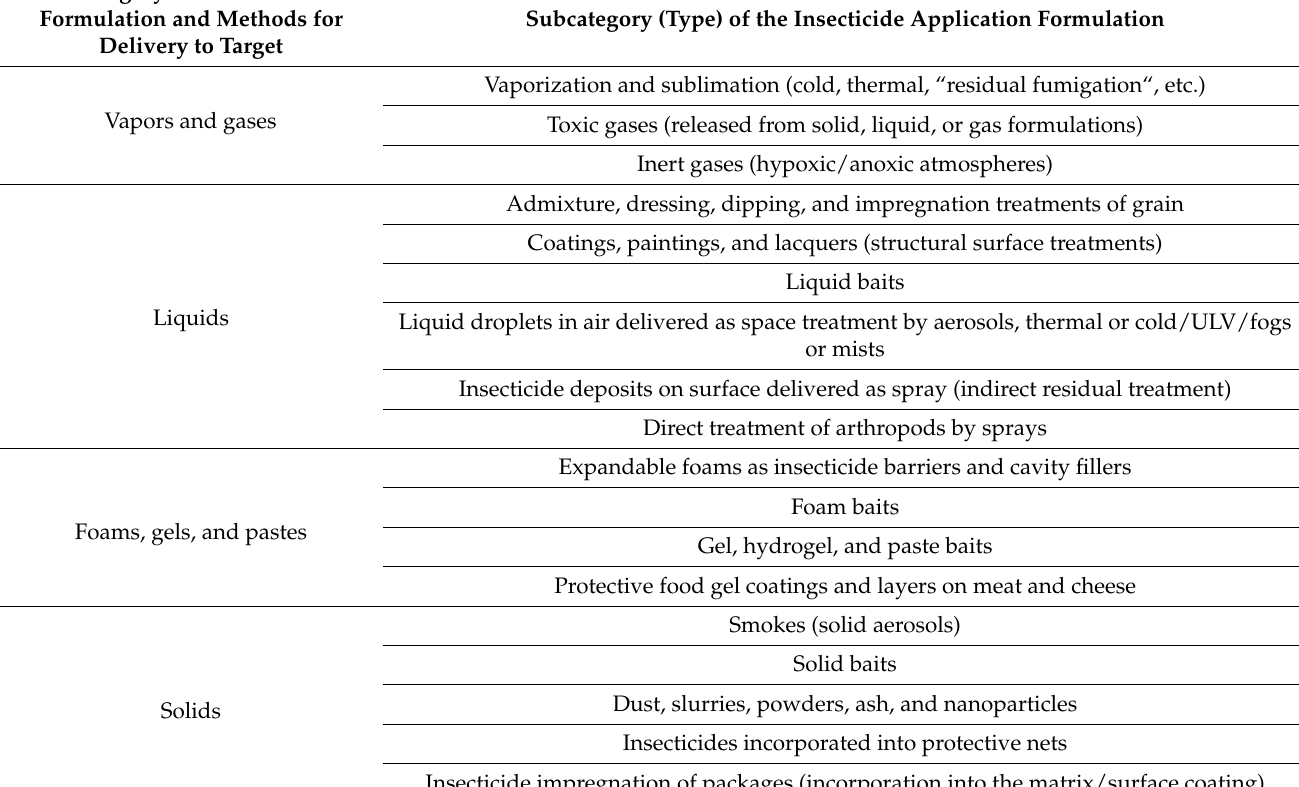
Table 1. Categories and subcategories of insecticides that are currently in use in stored-product protection. Category of Insecticide Formulation and Methods